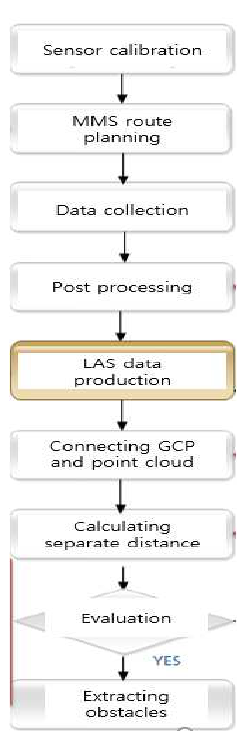
Figure 4. Process of extracting obstacles by MMS